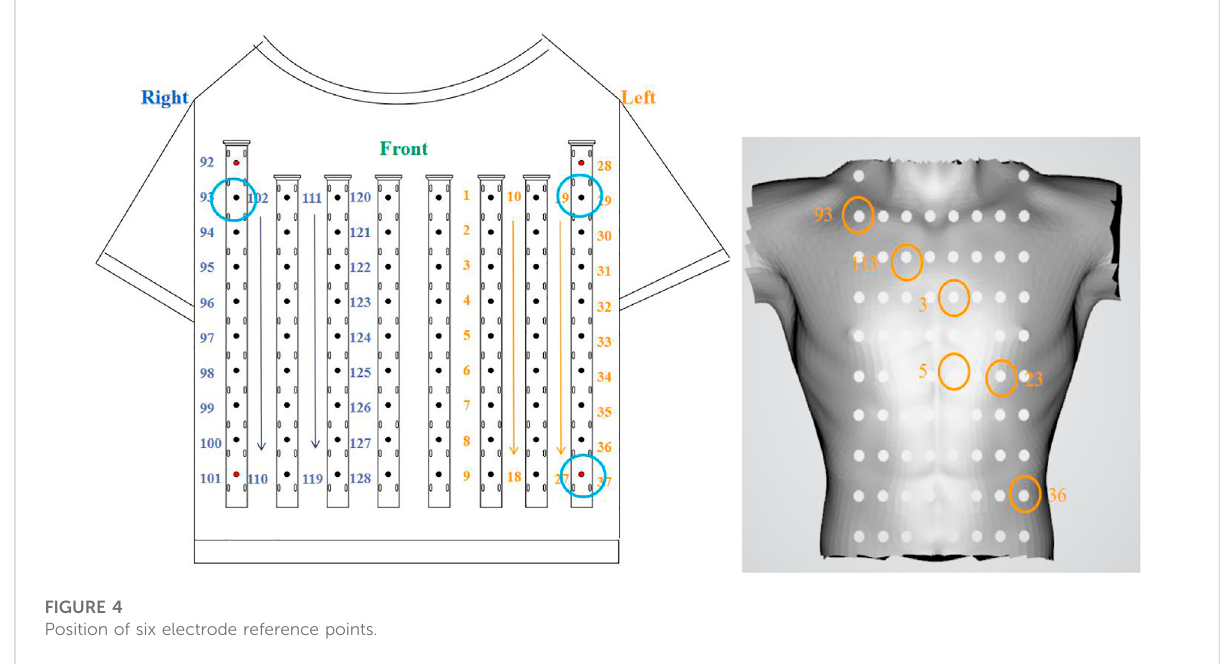
FIGURE 4 Position of six electrode reference points.